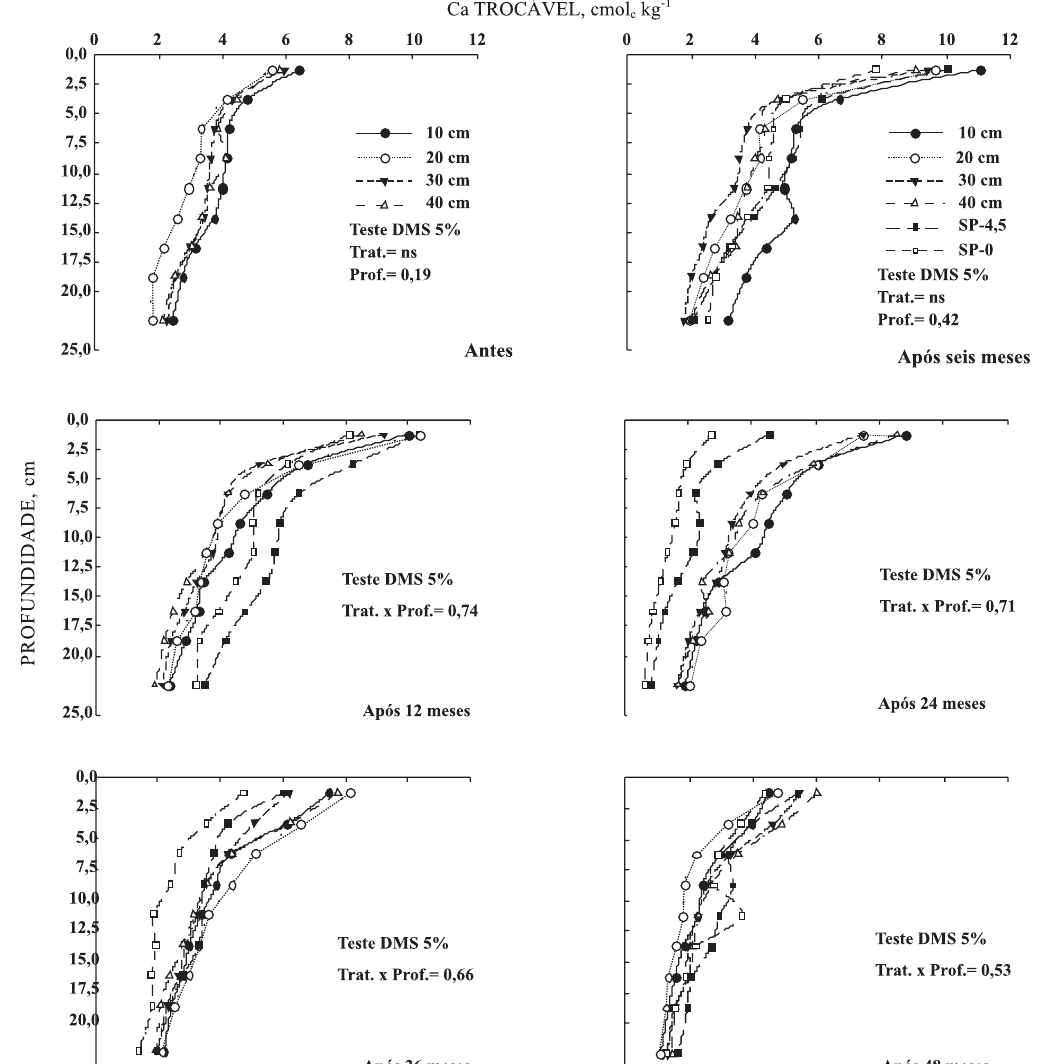
Figura 2. Teor de cálcio trocável em diferentes épocas da aplicação superficial de calcário em Latossolo Vermelho, sob sistema plantio direto e integração lavoura-pecuária, com diferentes pressões de pastejo no inverno (ns: não